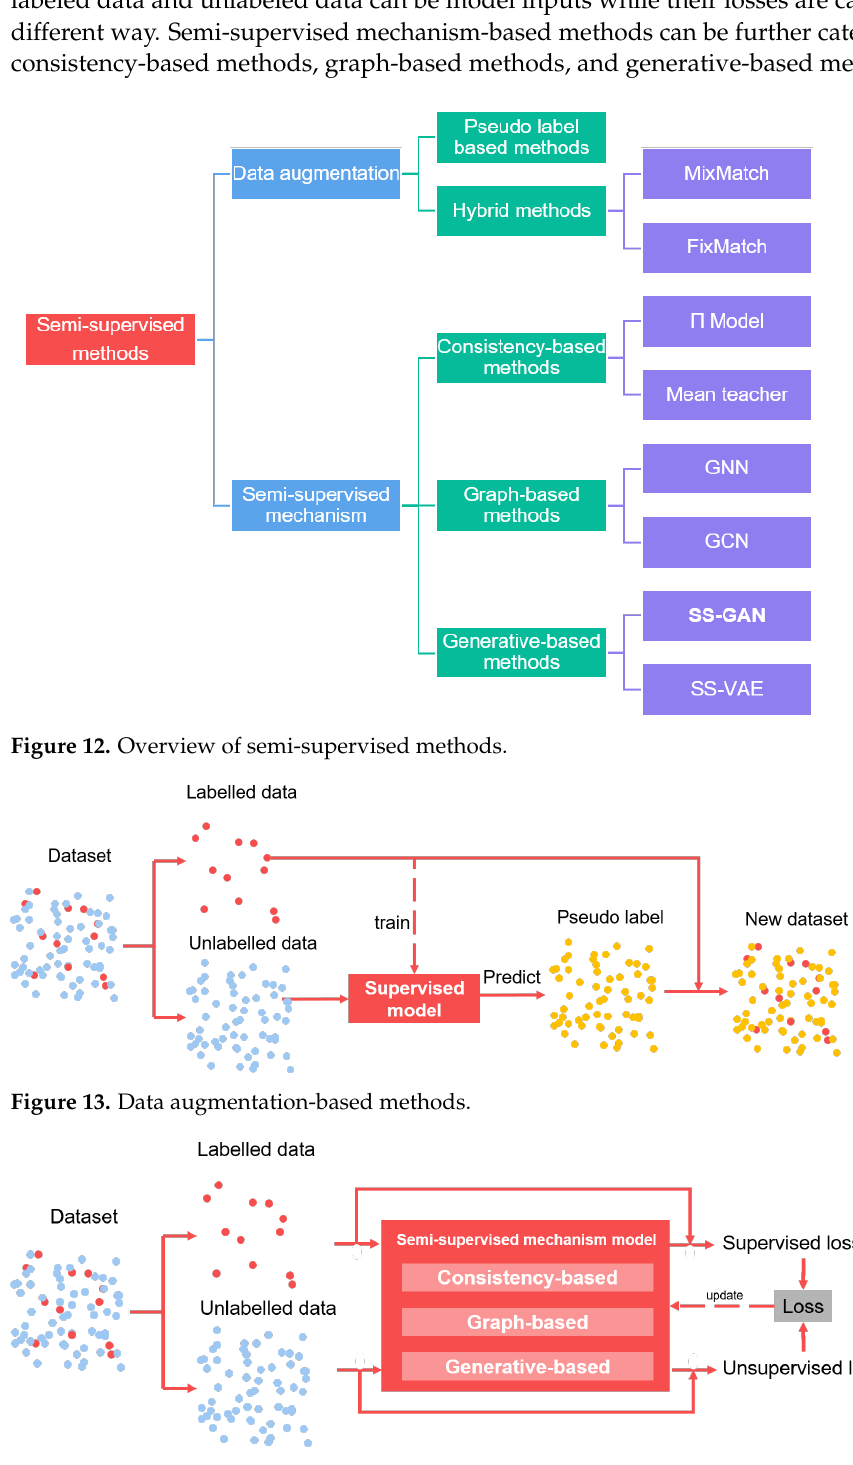
Figure 14. Semi-supervised mechanism-based